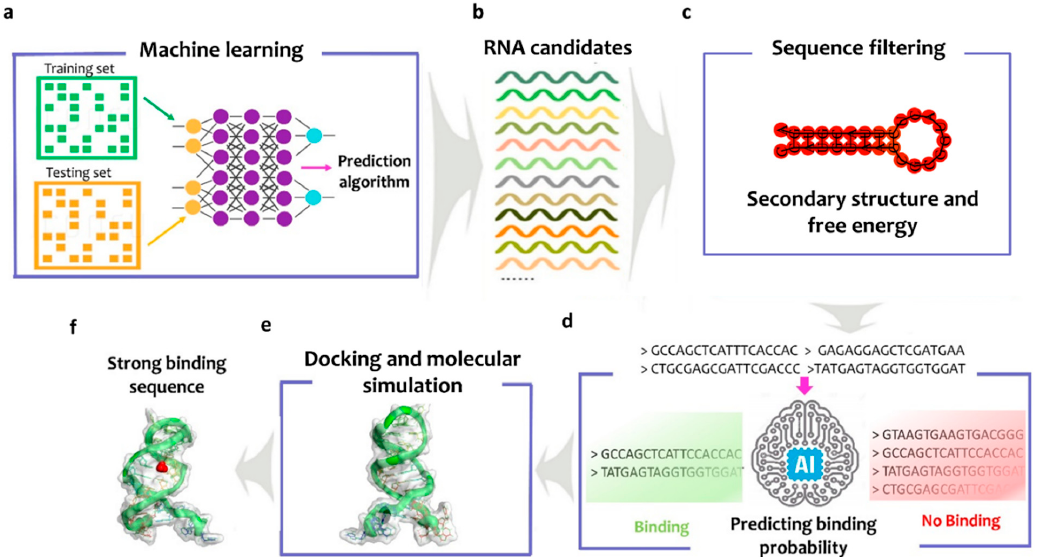
Figure 1. Predicting aptamer sequence using Smart-SELEX: ( a ) training the machine learning model using data collected from the literature data, ( b ) generating the initial RNAs library (10 8 ), ( c ) filtering the sequences by calculating the free energy and increasing the number of the loops, ( d ) using the machine learning model developed to predict the binding probability of each sequence with the analyte and ranking them from high to low, ( e ) docking the sequences with the positive and negative analytes and calculating the binding energy, and ( f ) the final aptamer with high affinity towards the target.